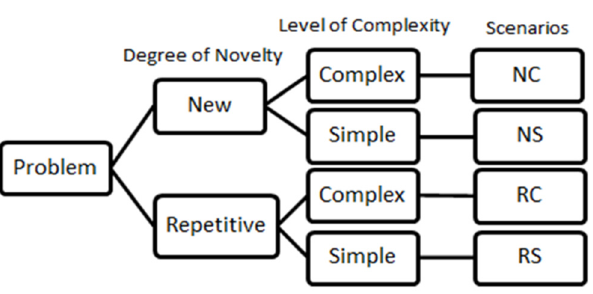
Figure 3. Classification of problems.